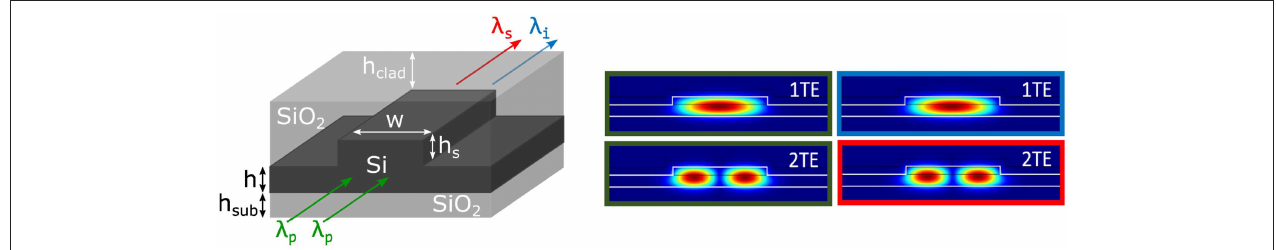
FIGURE 1 | (Left) Sketch of the geometry of the rib waveguide (not in scale). w is the width of the waveguide, h s the height of the strip, h the height of the slab, h clad the height of the cladding over the strip and h sub the height of the substrate. The two input pump photons, at λ p , are converted into signal and idler photons, respectively, at λ s and λ i . (Right) Simulated intensity profiles of the spatial modes excited in the rib waveguide at λ = 1.55 µ m . The color code of the boxes refers to the arrow colors used in the left panel and indicates a 1221 modal